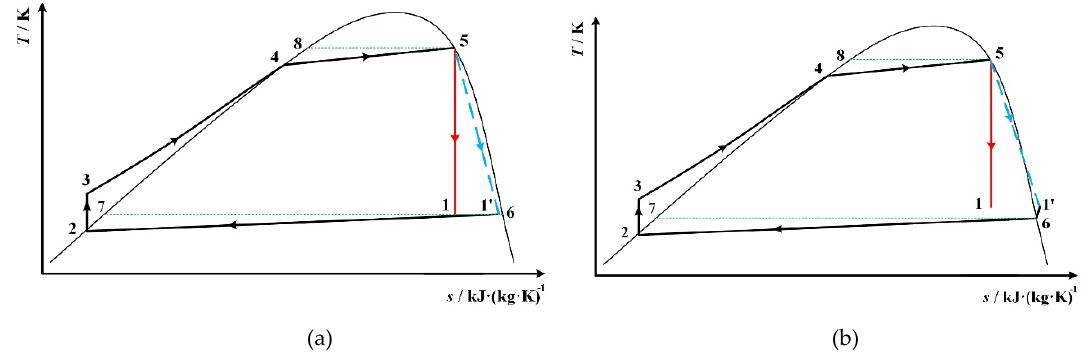
Figure 8. Subcritical ORC using single screw expander with wet zeotropic mixture as working fluid when considering isentropic efficiency of expander: (a) expander outlet at vapor-liquid two-phase region; (b) expander outlet at superheated region.